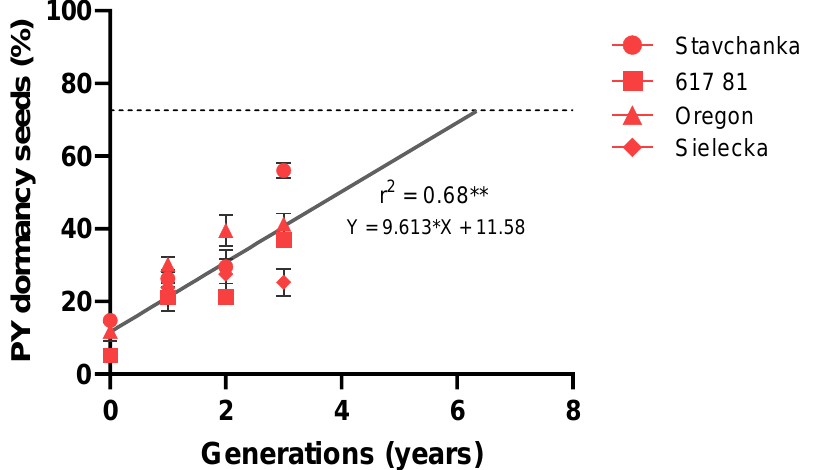
According to the mean projections (Figure 2), it could be expected that the PY level of EU cultivars after 6 years of the spontaneous crosses with the naturalized AR population would reach a similar value to the latter population (~70%).